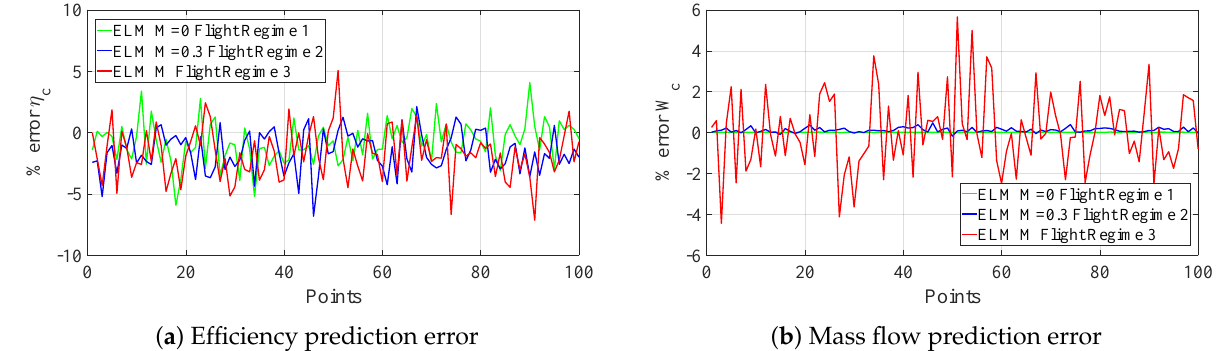
Figure 14. ELM error of compressor degradation prediction with input vector 3 or 4.